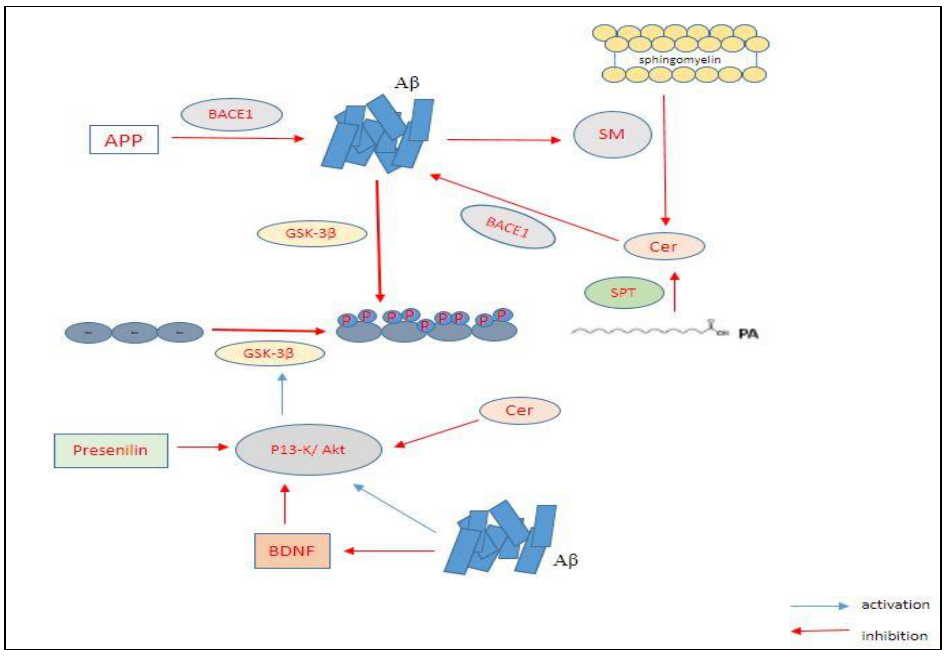
Figure 2. Interactions occurring between amyloid beta (Aβ), hyperphosphorylated tau, glycogen synthase kinase 3β ( GSK- 3β ) and ceramides (cer). glycogen synthase kinase 3 β (GSK-3 β ) and ceramides